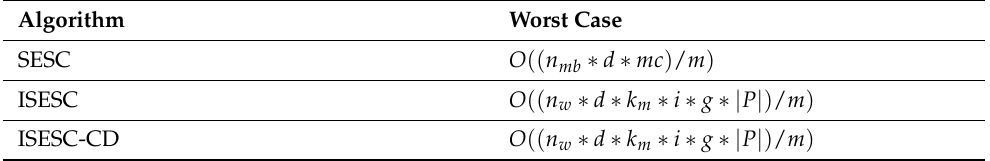
Table 1. Asymptotic computational complexity analysis of the evolutionary